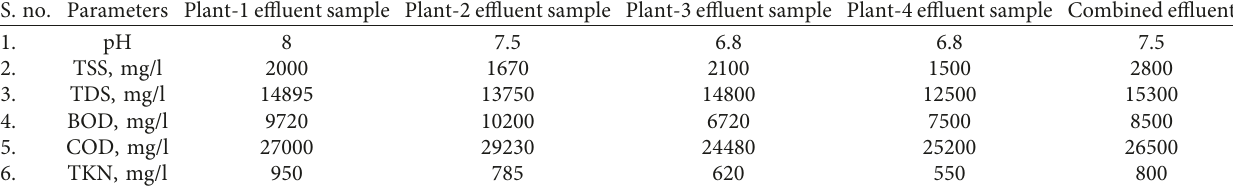
Table 1: Raw effluent characteristics from pharma